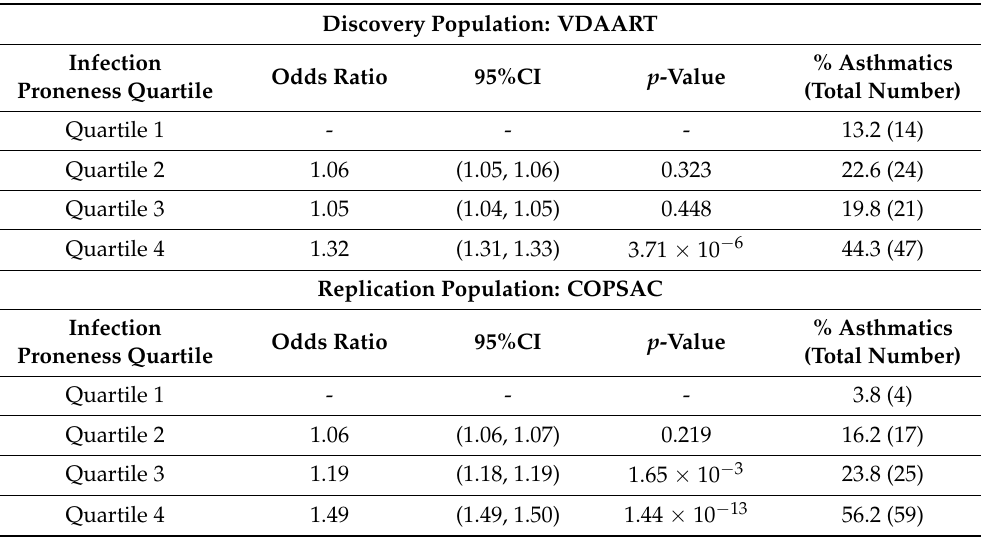
Table 2. Infection-prone children were more likely to be asthmatic in both VDAART and COPSAC cohorts. Odds ratios, 95% confidence intervals (CIs), and p -values are shown for logistic regression models with a dichotomous yes/no for physician diagnosis of asthma by age 6. The lowest quartile of infection proneness was used as the reference group. Models in VDAART were adjusted for sex, race, ethnicity, study site, BMI, and year 6 vitamin D level; models in COPSAC were adjusted for sex, BMI, year 6 vitamin D level, and fish oil intervention